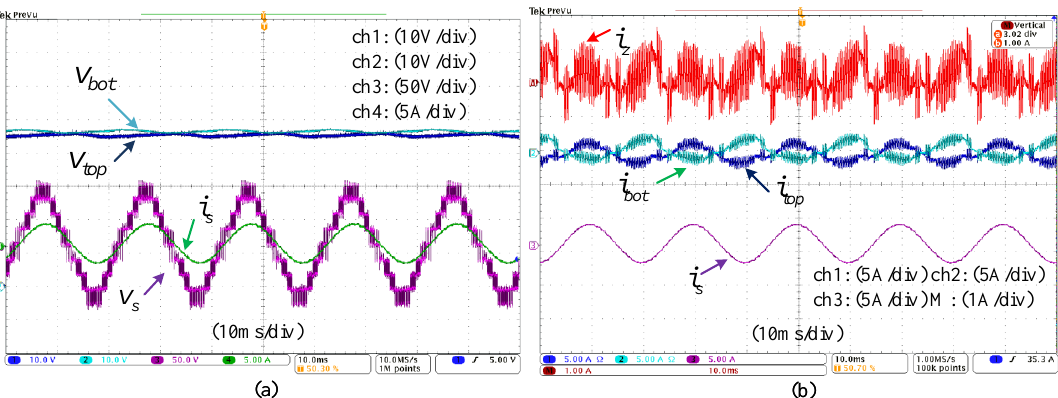
Figure 19. Experiment results with PSC1. ( a ) Phase voltage v s , phase current i s , capacitor voltage of SM v top and v bot ; ( b ) circulating current i z , phase current i s , arm current i top , and i bot .